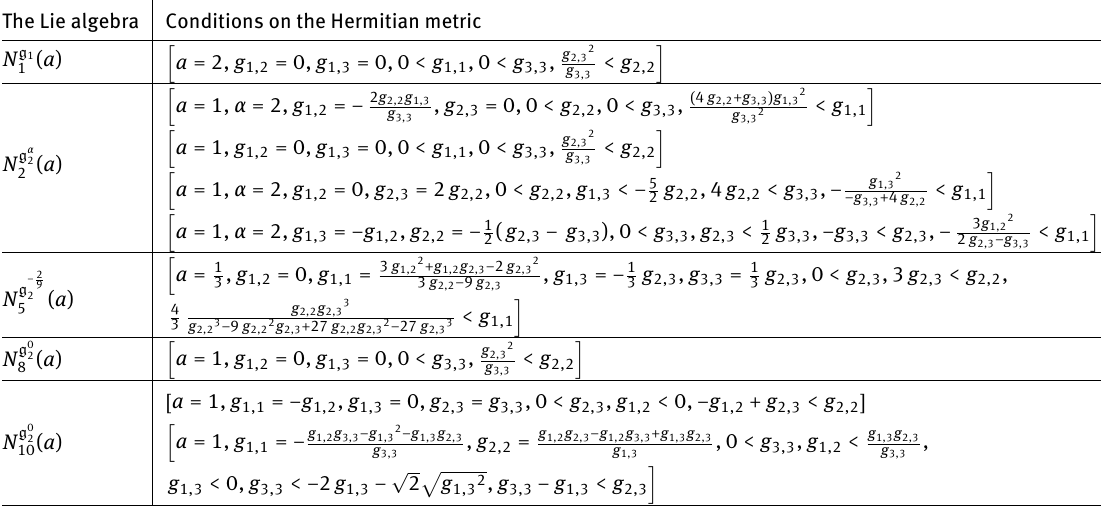
The Lie algebra Conditions on the Hermitian